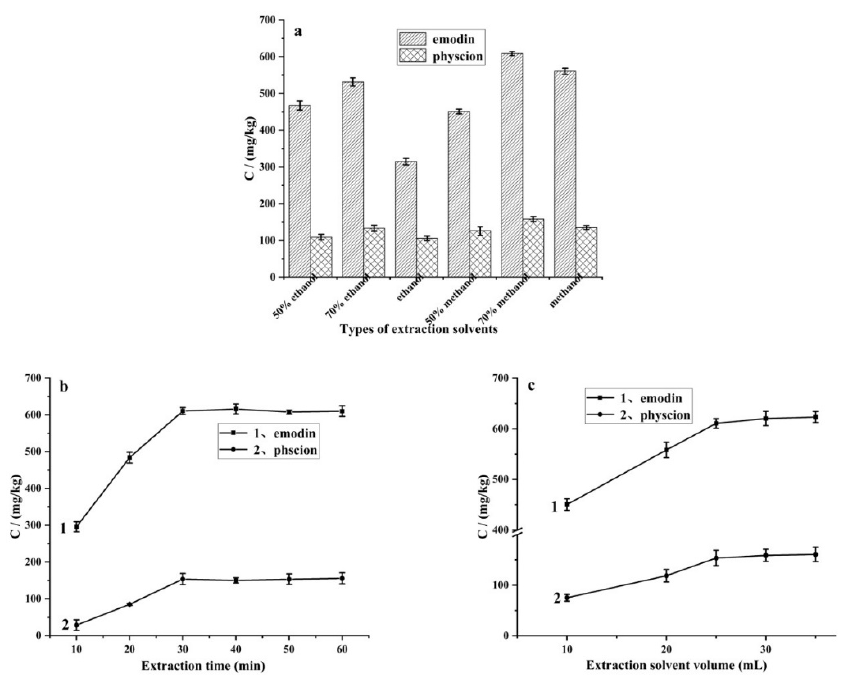
Figure 2. The effect of the type of extraction solvents ( a ), extraction time ( b ), and volume of extrac- tion ( c ) on the extraction efficiency. ( n = 3) Conditions: ( a ) Volume of extraction solvent, 25 mL; extraction time, 60 min. ( b ) Extraction solvent, 70% methanol; volume of extraction solvent, 25 mL. ( c ) Extraction solvent, 70% methanol; extraction time, 30 min.